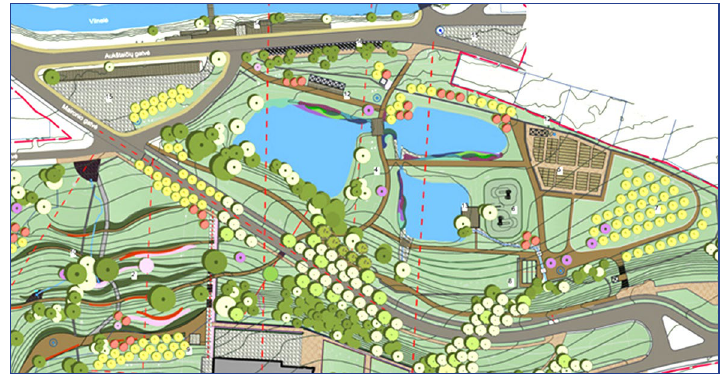
Figure 3. Preliminary design of the renovated public place “Missionary Garden” (source: Vilnius city municipality)